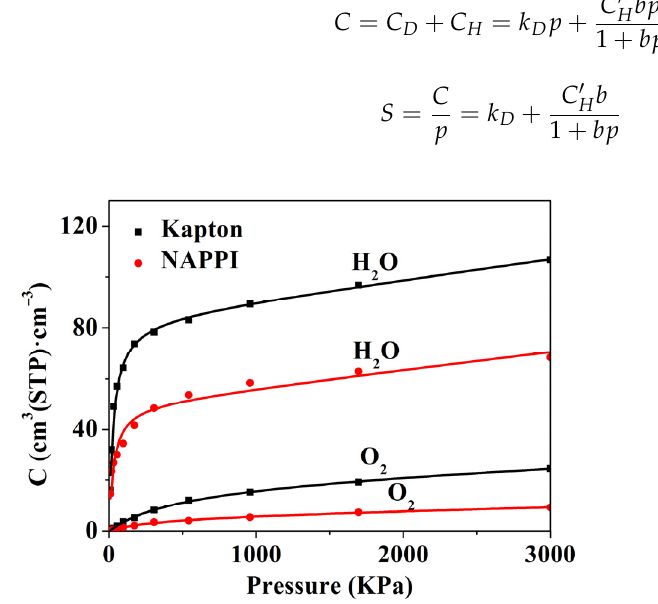
Figure 12. Sorption isotherms of O 2 and H 2 O in NAPPI and Kapton.